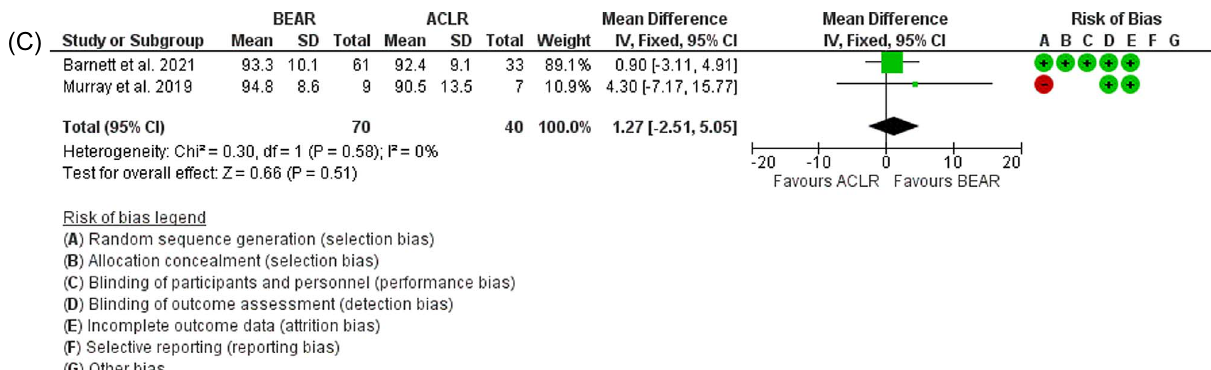
Figure 4. (A) Forest plot showing the KOOS scores 2 years postoperatively (symptoms section) in ACLR and BEAR. (B) Forest plot showing the KOOS scores 2 years postoperatively (knee-related quality of life section) in ACLR and BEAR. (C) Forest plot showing the KOOS scores 2 years postoperatively (pain section) in ACLR and BEAR. (D) Forest plot showing the KOOS scores 2 years postoperatively (activities of daily life section) in ACLR and BEAR. (E) Forest plot showing the KOOS scores 2 years postoperatively (sports and recreation section) in ACLR and